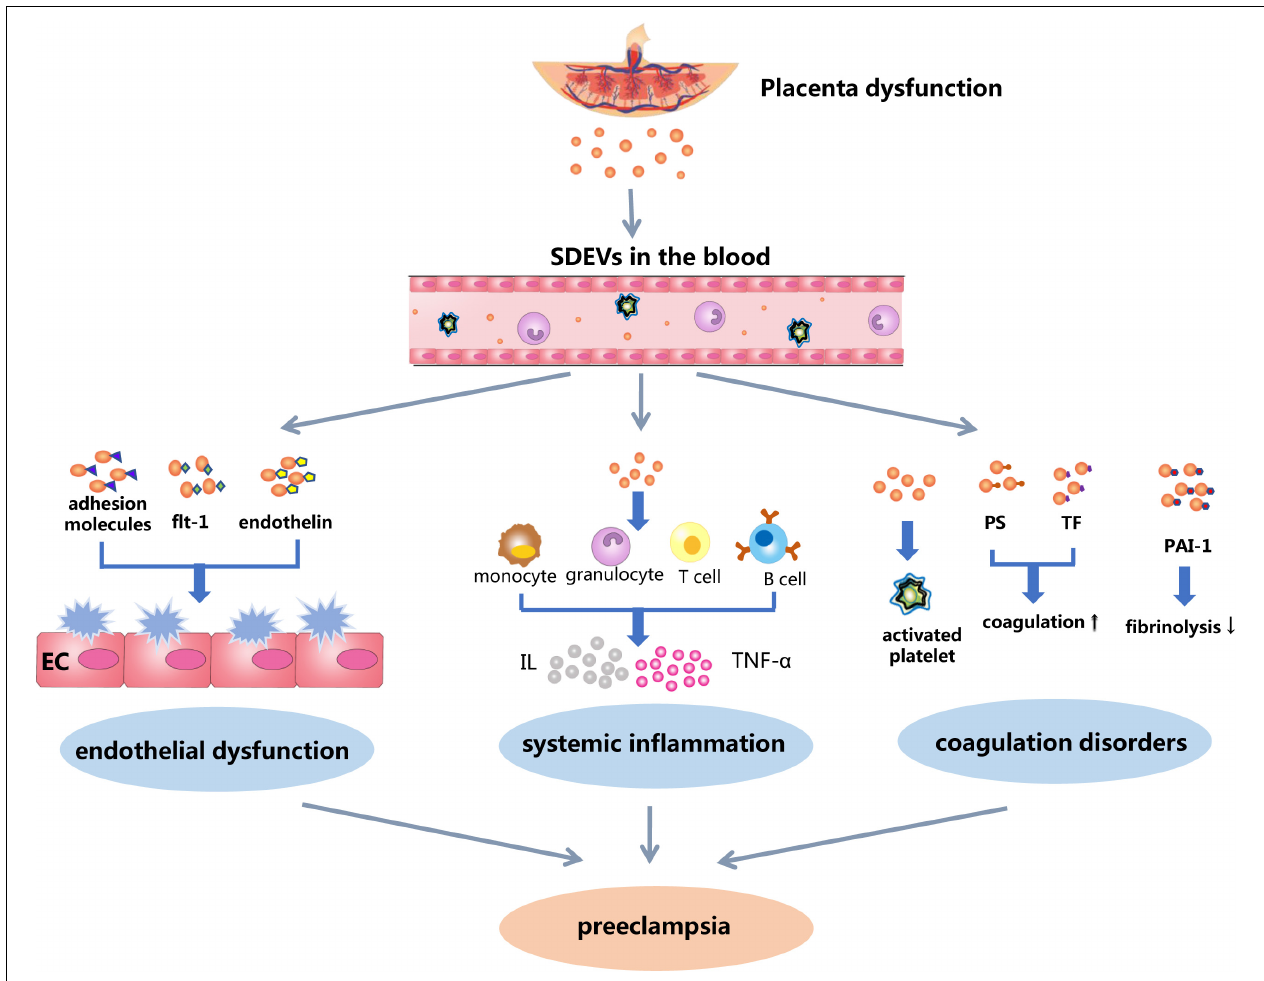
FIGURE 1 | A schematic illustration of SDEVs in the pathophysiology of preeclampsia. Ischemic and hypoxic injures to the placenta induce syncytiotrophoblast cells to undergo apoptosis and release SDEVs into the maternal circulation, where they induce endothelial injury, inflammation, and hypercoagulation. It remains debatable as whether SDEVs from women with normal pregnancies and those from PE patients have similar or distinct structures and biological activities. If it is the former, the same process could occur during normal pregnancies, but at a much lower level. If it is the latter, SDEVs from the two conditions may elicit very distinct systemic responses. In this case, the process depicted here is developed based on research and clinical findings from